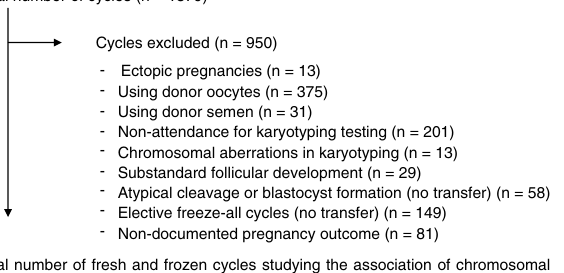
Figure 1. Flow chart of data selection